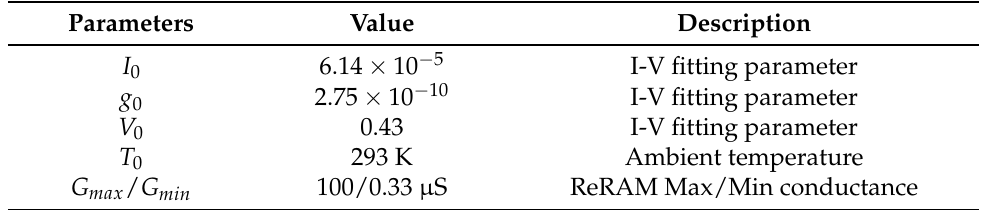
Table 2. Fitting parameters.